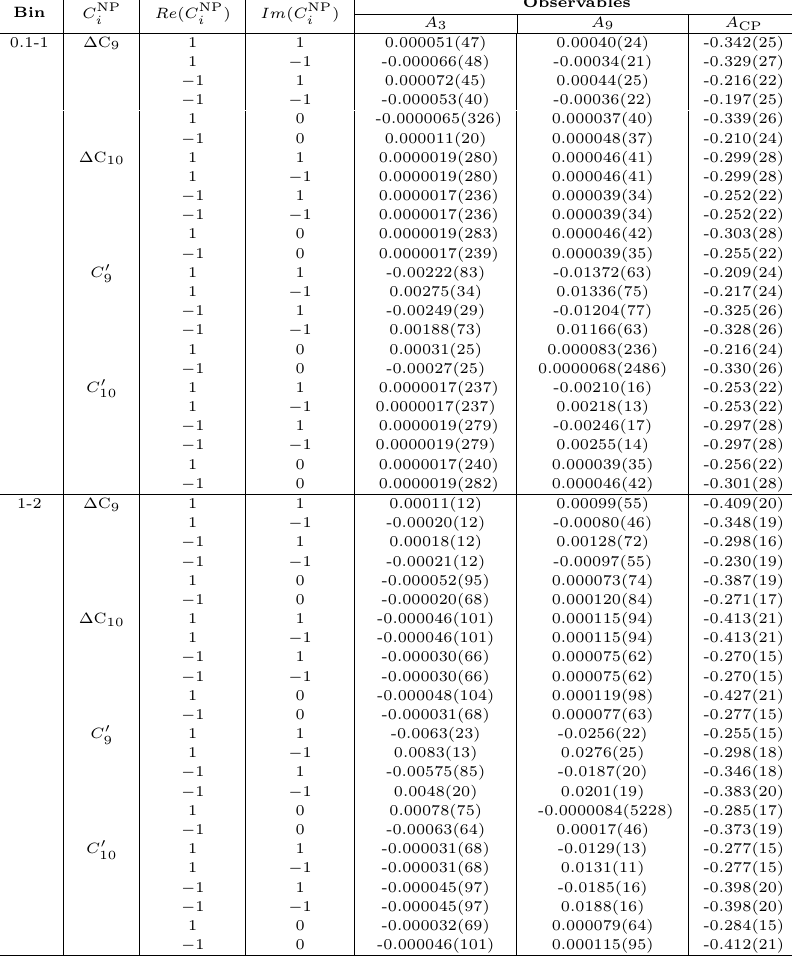
Table 22 . The dependence of the asymmetric observables corresponding to B ± → ρ ± ll on the real and imaginary parts of the NP WC’s ∆ C few benchmark values of the real and imaginary parts of the corresponding